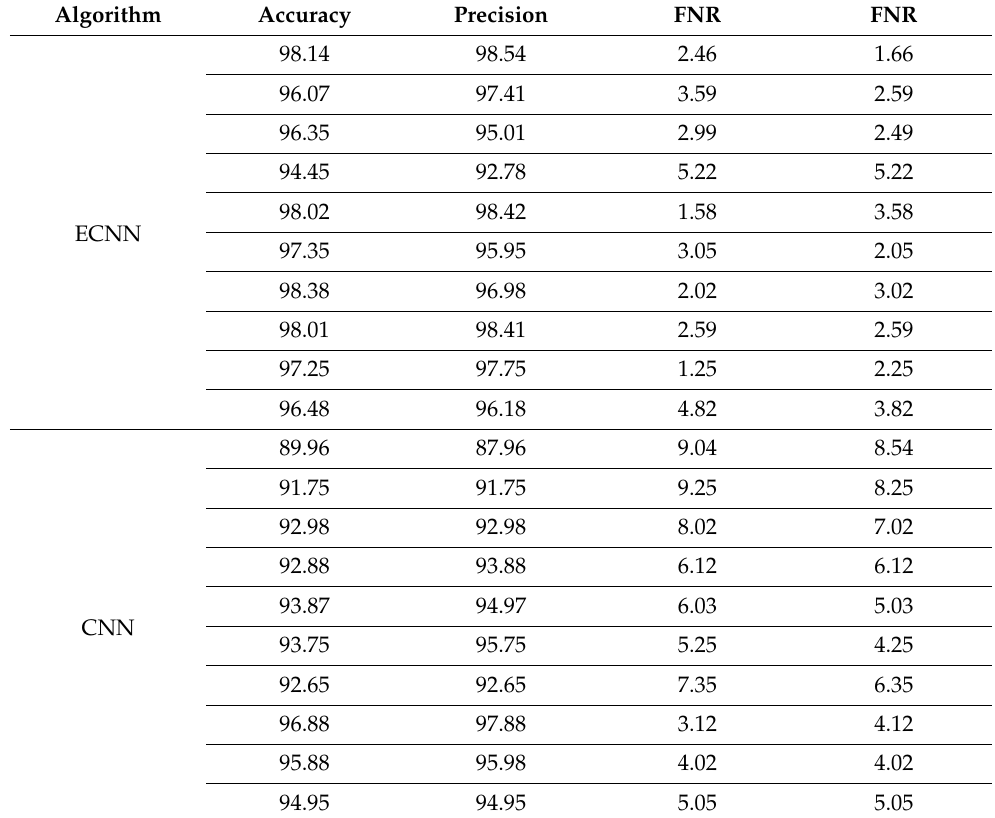
Table 3. Iterated performance-value list for accuracy, precision, false positive, and false negative between ECNN and CNN algorithms.